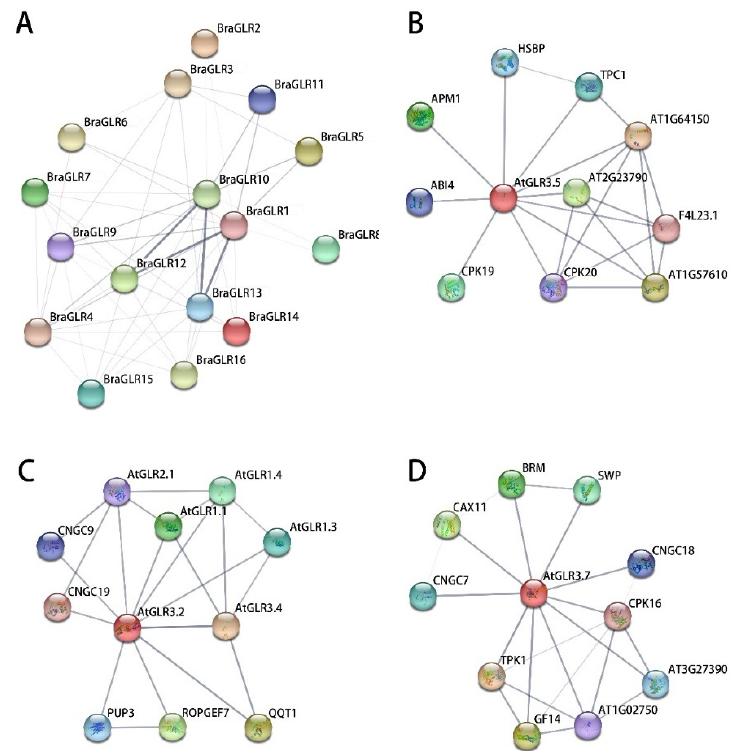
Figure 9. Predictive interaction network of GLRs. ( A ) Predictive analysis of interaction network of GLR proteins in B. rapa . ( B ) Predictive analysis of interaction network of BraGLR5 homolog AtGLR3.5. ( C ) Predictive analysis of interaction network of BraGLR1 homolog AtGLR3.2. ( D ) Predictive analysis of interaction network of BraGLR3 homolog AtGLR3.7. Minimum required interaction score of 0.150; default settings were used for the other parameters. Network nodes represent proteins, edges represent protein–protein associations.